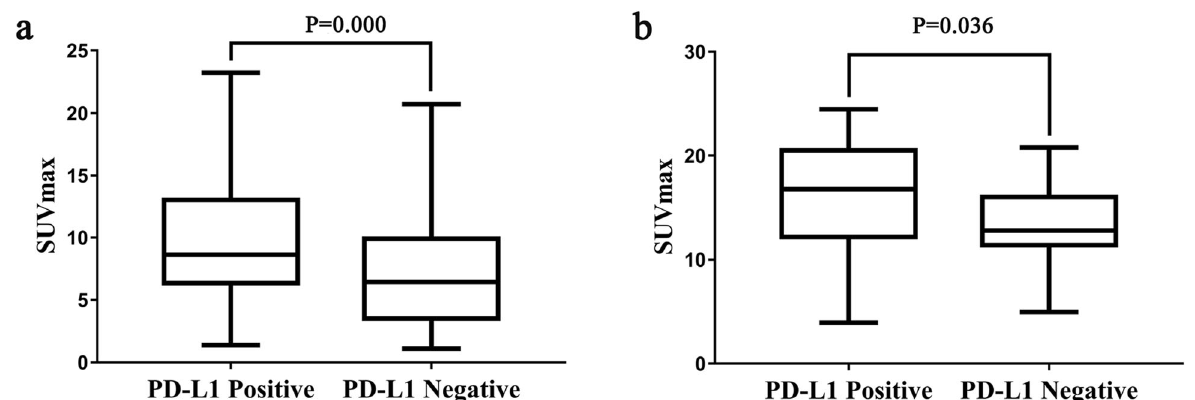
Fig. 4 The correlation between SUVmax and PD-L1 expression in AC ( a ) and SCC ( b ),